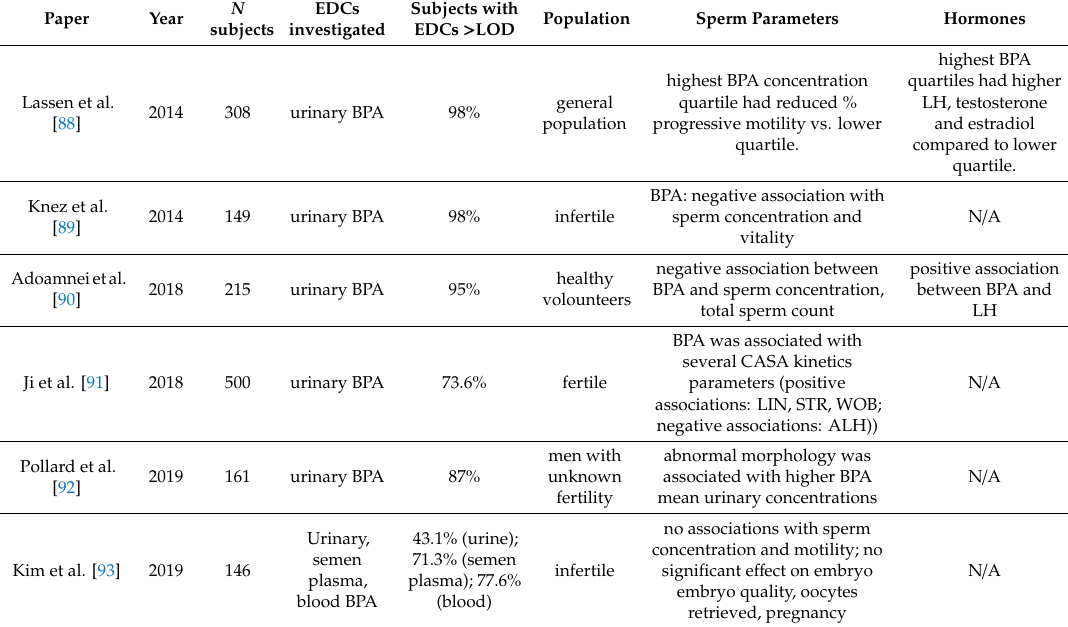
Table 2. Summary of recent available clinical evidence of Bisphenol A e ff ects on sperm parameters and reproductive